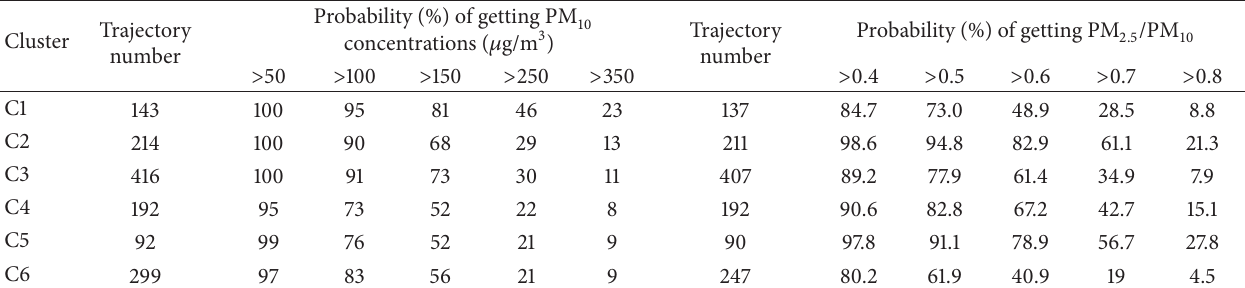
Table 1: Probability of cluster trajectories to be associated with different ranges of PM 10 concentration and of PM 2.5 to PM 10 ratio at Gazipur station.